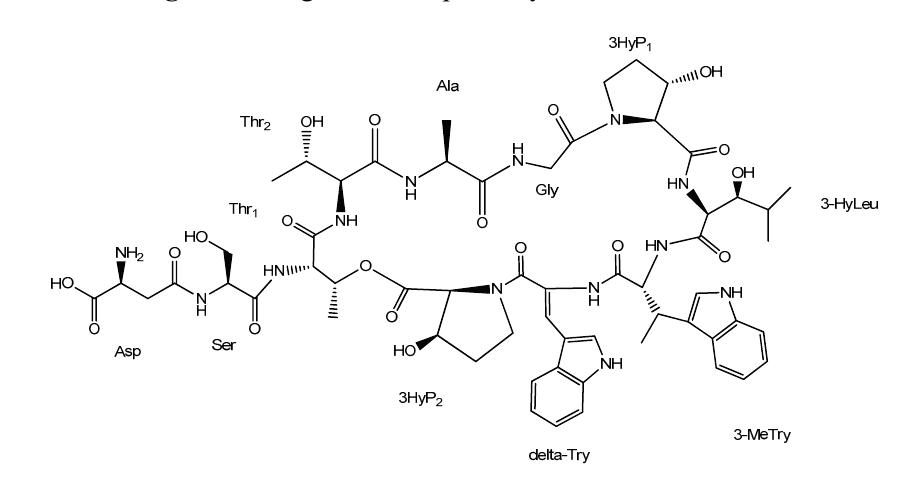
Figure 4. Structure of